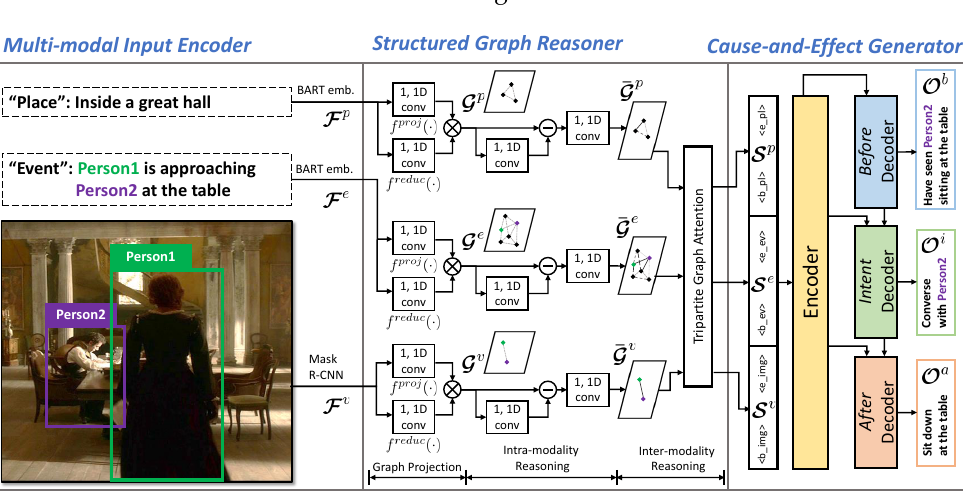
Figure 2. Illustration of Cause-and-Effect BART (CE-BART), which is composed of a multimodal input encoder, structured graph reasoner, and cause-and-effect generator. (1) Multimodal input encoder: we first obtain multimodal features ( F v , F e , F p ) using pre-trained models. We used mask R-CNN for the visual inputand the BART word-embedding layer for textual inputs. (2) Structured Graph Reasoner (SGR): we then built semantic graphs ( G v , G e , G p ) and strengthened their representations ( S v , S e , S p ) by capturing the intra- and inter-modality relations. (3) Cause-and-Effect Generator (CEG): we finally generated cause-and-effect descriptions ( O b , O i , O a ) using the BART-based transformer architecture, which considers the causal relations among